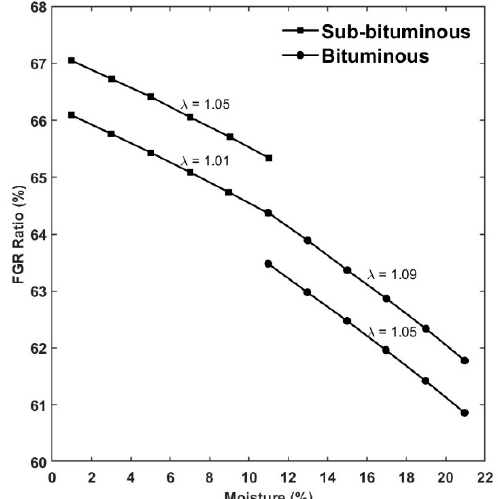
Figure 2. Effect of moisture in coal on fuel gas recycle ratio.